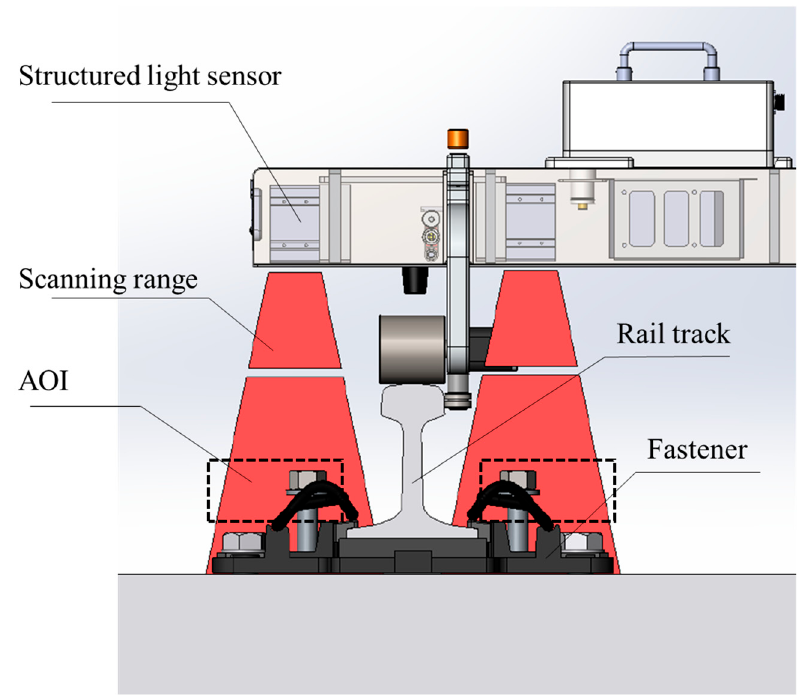
Figure 8. Illustration of the fastener extraction method.